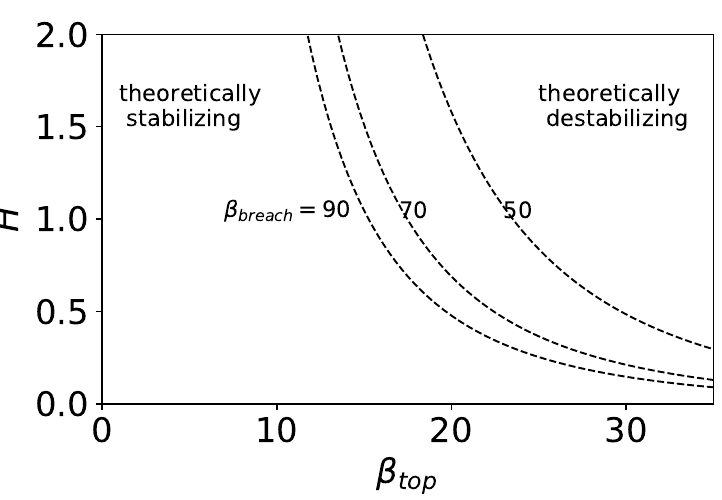
Figure 4. Illustration of the criterion expressed by Equation (8). For a given sand type and in situ porosity, the breaching mode is determined by three parameters: the breach height H , the angle of the breach face β breach and the the slope angle at the top of the breach face β top . The criterion curve is plotted for three angles of the breach face: 90 ◦ , 70 ◦ , and 50 ◦ . For a given breach face angle, the corresponding contour line separates the regions in the ( H , β top ) plane that result in dH / dx < 0 (left side of dashed line, stabilizing) and dH / dx > 0 (right side of dashed line, destabilizing). Sand parameters correspond with GEBA type as defined in Table 1 and n 1 =